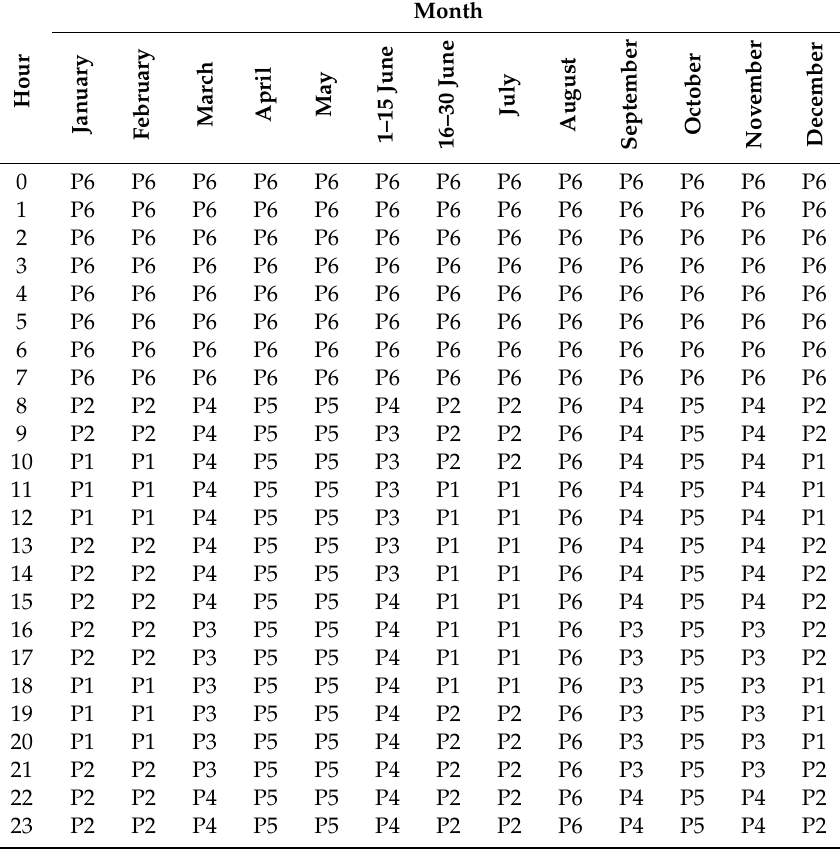
Table 3. Period di ff erentiation as a function of hour and month to define the energy